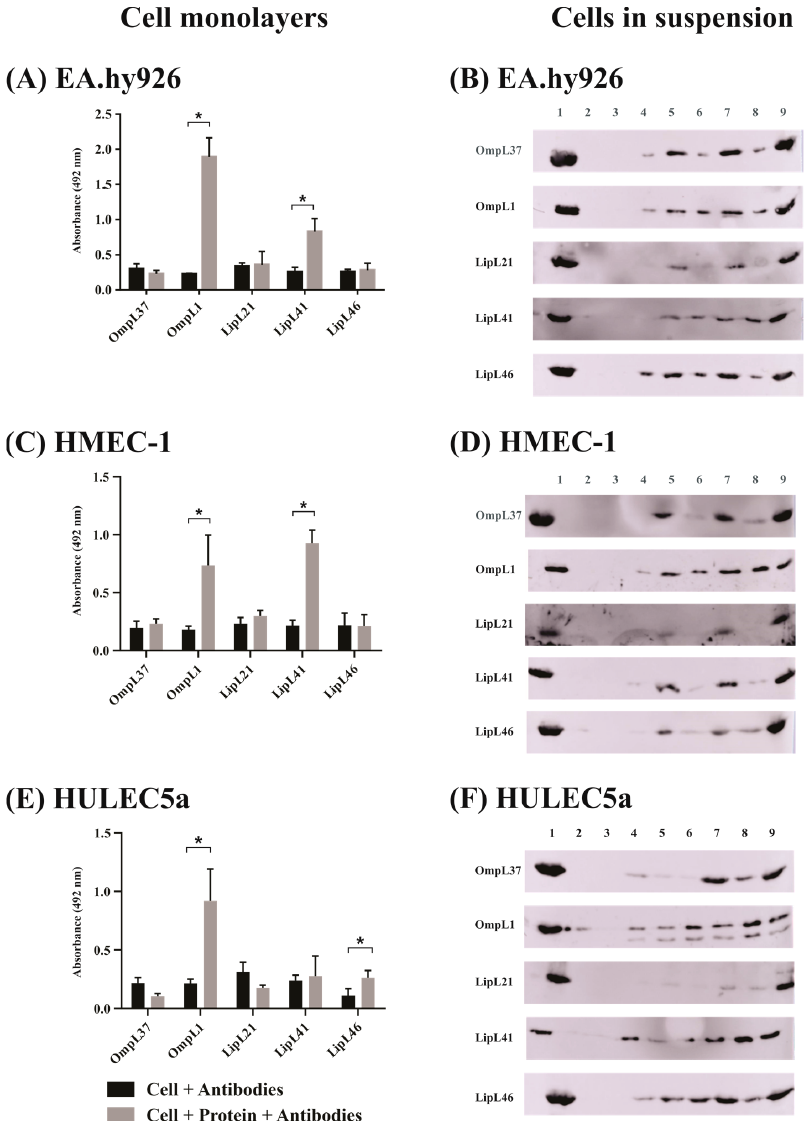
Figure 2. Evaluation of adhesion potential of the major outer membrane proteins of L. interrogans with endothelial cells. Binding of five recombinant membrane proteins, OmpL37, OmpL1, LipL21, LipL41, and LipL46, of L. interrogans to mammalian cells was assessed with cell monolayers (immobilized assay) and detached cells (suspension assay). ( A , C , E ) : Cell monolayers ( left side ). Ninety-six-well plates were seeded with 10 5 cells/well, and cell confluence was achieved at 37 ◦ C under 5% CO 2 for 24 h. One microgram of each recombinant protein was resuspended in cell media and 1 µ M aprotinin was added for 2 h. Wells without the addition of the proteins were used as negative control. Samples were incubated with anti-recombinant proteins (1:1000) for 1 h. Reaction was detected with anti-mouse IgG-peroxidase (1:5000). The binding of the proteins was compared to the negative controls by the two-tailed t -test ( p < 0.05) showed by *. ( A ): EA.hy926, ( C ): HMEC-1 and ( E ): HULEC5a. ( B , D , F ) : Cells in suspension ( right side ). After cell trypsinization, 2 × 10 5 cells were resuspended in cell media with different protein concentrations in the presence of 1 µ M aprotinin for 2 h. The samples were centrifuged at 130 × g for 10 min, and the interaction was assessed by Western blotting. ( B ): EA.hy926, ( D ): HMEC-1 and ( F ): HULEC5a. Lanes were described as 1: recombinant protein as positive control; 2–3: pellet and supernatant of negative control without addition of recombinant proteins, respectively; 4–5: pellet and supernatant with addition of 2.5 µ g of protein, respectively; 6–7: pellet and supernatant with addition of 5 µ g of protein, respectively; and 8–9: pellet and supernatant with addition of 10 µ g of protein,